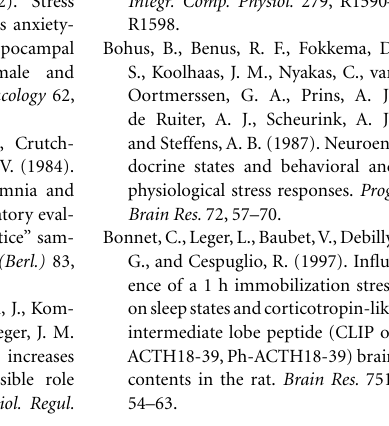
FIGURE 4 |Working model of the prolactinergic hypothesis of stress-induced REMS rebound. Stressors (including REMS deprivation) increase serotonin release from the Raphe nuclei (1), which, in turn, could stimulate the release of PRL from the lateral hypothalamic area – LHA (2). Descending PRL projections from the LHA to the Raphe nuclei would close the self-stimulatory circuit, producing a further release of serotonin. In parallel, serotonergic